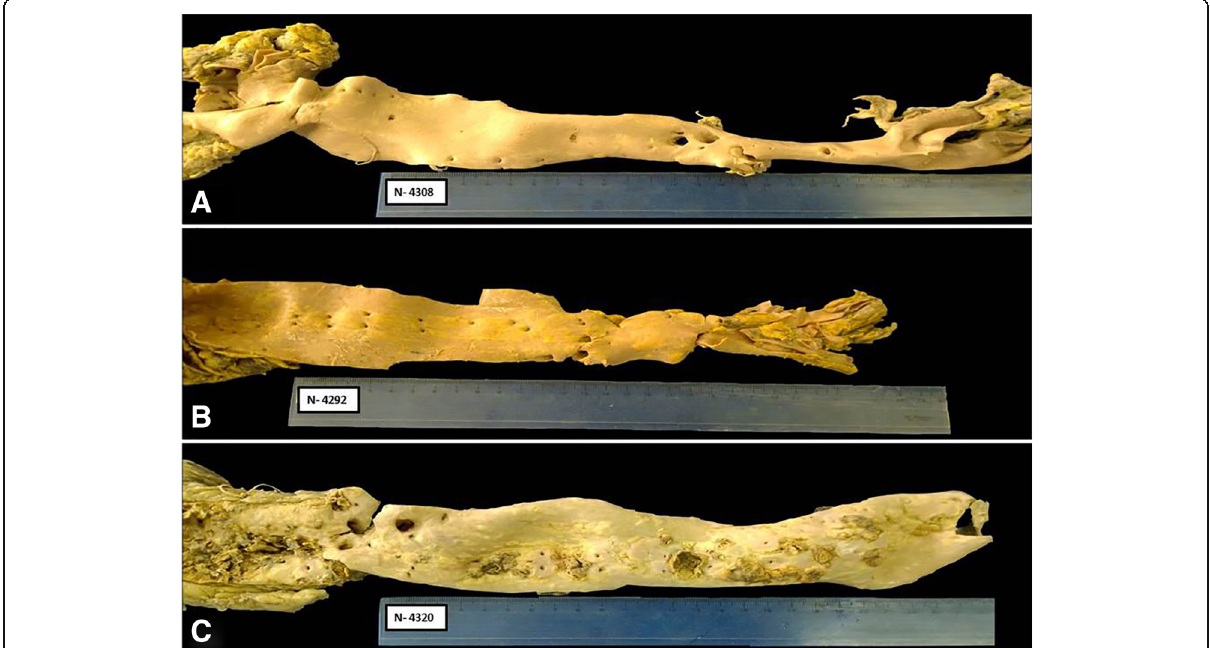
Fig. 1 Macroscopy of 10% formaldehyde-fixed aortas in elderly patients with or without autopsied Aids in HC / UFTM, from 1982 to 2014. a Aorta showing a small amount of lipid stretch marks in all arterial extension, the intensity of atherosclerosis being classified as mild b Aorta showing atheromatous plaques in all arterial extension, the intensity of atherosclerosis being classified as moderate. c Aorta showing fibrous and atheromatous plaques with calcifications, the degree of atherosclerosis being classified as